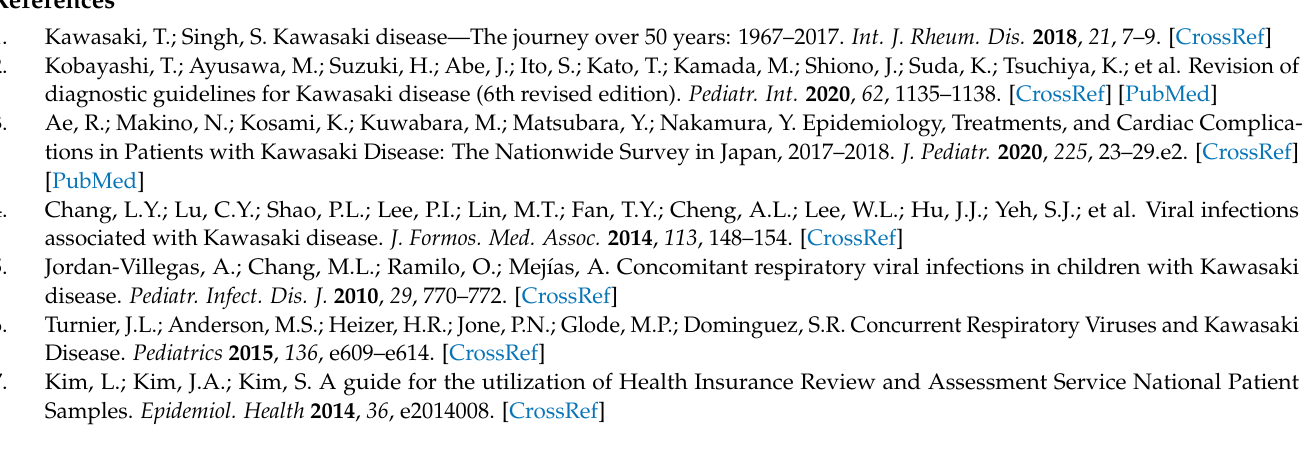
Table S2: Positive detection rates of virus during study period, Figure S1: Residual ACF correlogram and 95% confidence limits for newly diagnosed Kawasaki